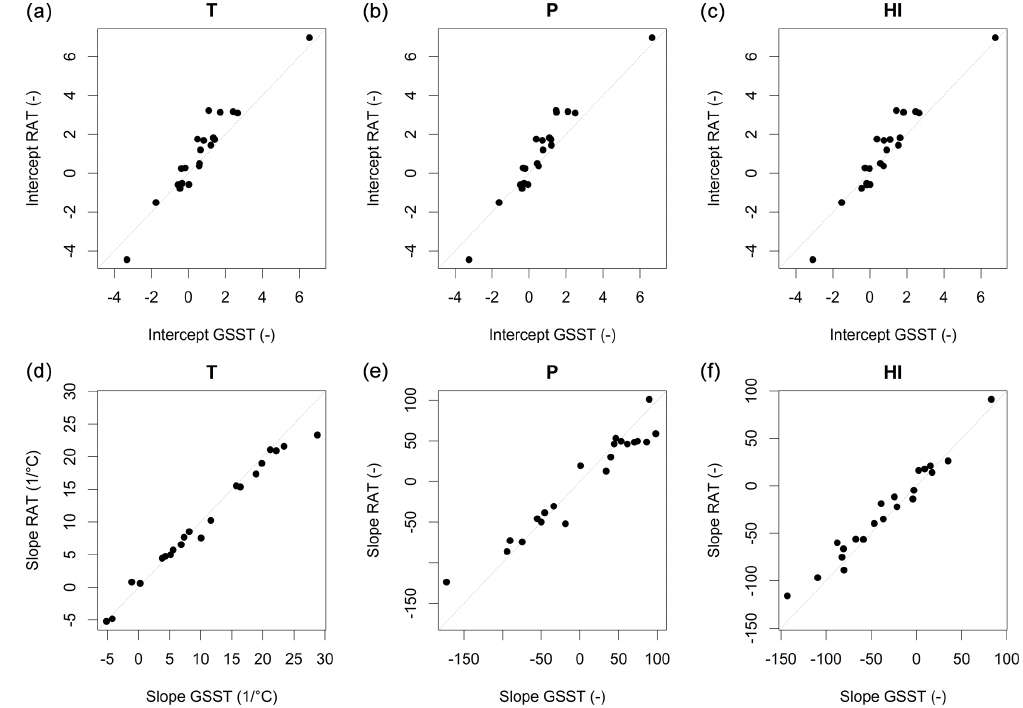
Figure 5. Comparison of slopes and intercept of linear regressions between streamflow bias and temperature ( T ), precipitation ( P ) and humidity index (HI) anomalies (from left to right) obtained by the GSST and the RAT procedures (each point represents 1 of the 21 test